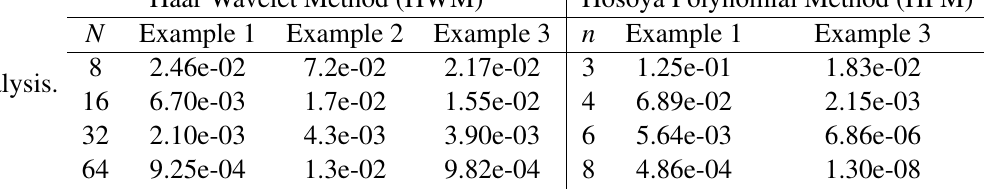
Table 3: Error Analysis.